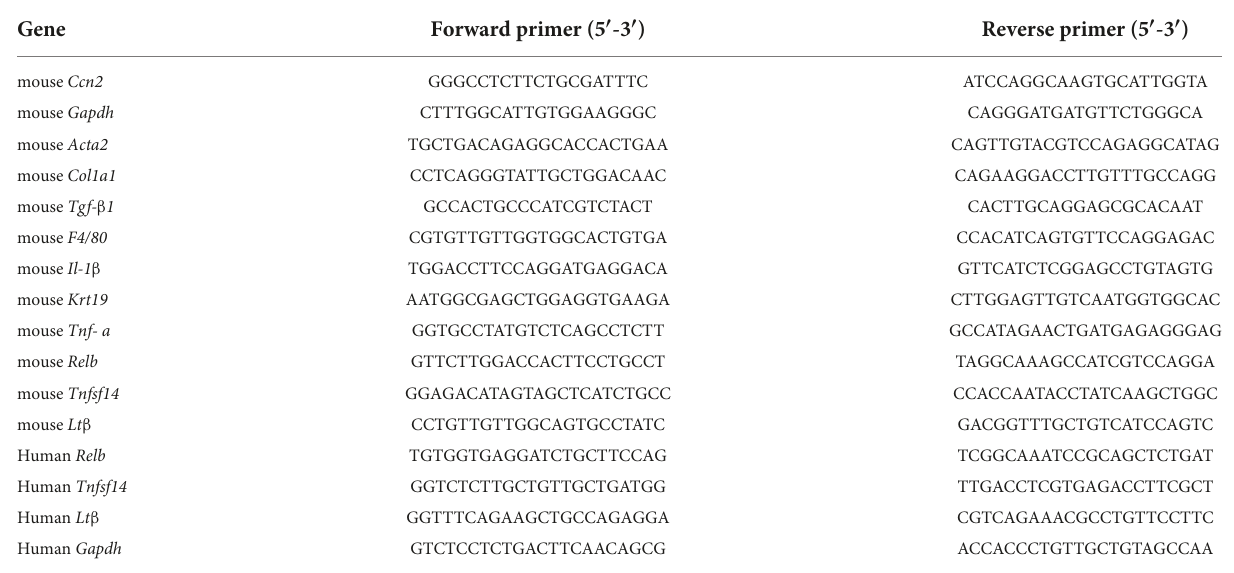
TABLE 1 Primer sequences used for RT-PCR